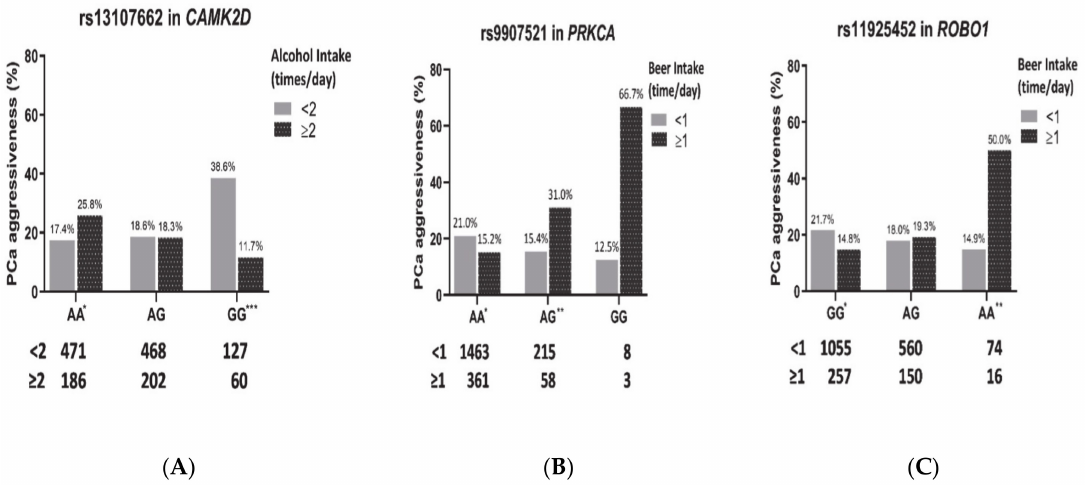
Figure 3. Prevalence of prostate cancer aggressiveness by the selected SNPs and alcohol intake behaviors. ( A ) Interaction of heavy alcohol intake and rs13107662 in CAMK2D ; ( B ) interaction of heavy beer intake and rs9907521 in PRKCA ; ( C ) interaction of heavy beer intake rs11925452 in ROBO1 . Note: *: p < 0.05, **: p < 0.01, ***: p <